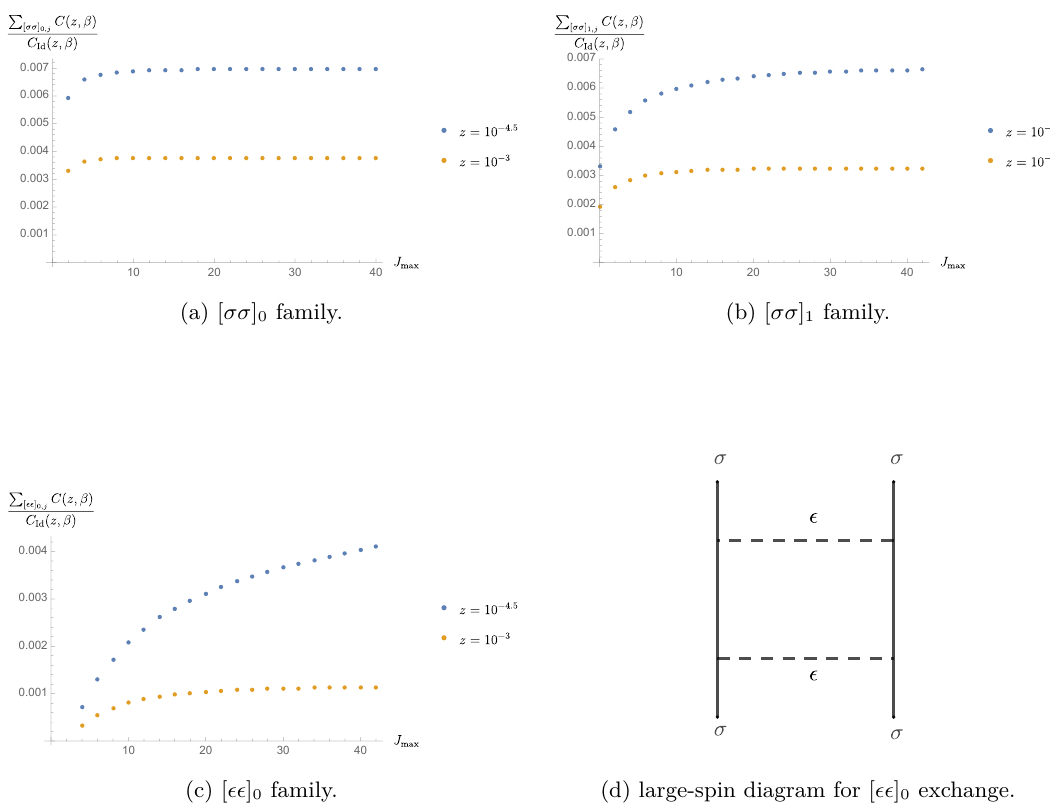
Figure 4 . Partial sum contributions to C ( z, β = 5 ) for the first three leading families as a function of the maximal spin. The [ σσ ] 0 family converges for any z , but other families, especially [ (cid:15)(cid:15) ] 0 , are very sensitive to large spins. Figure (d) shows how the exchange of [ (cid:15)(cid:15) ] 0 can contribute as log 2 z